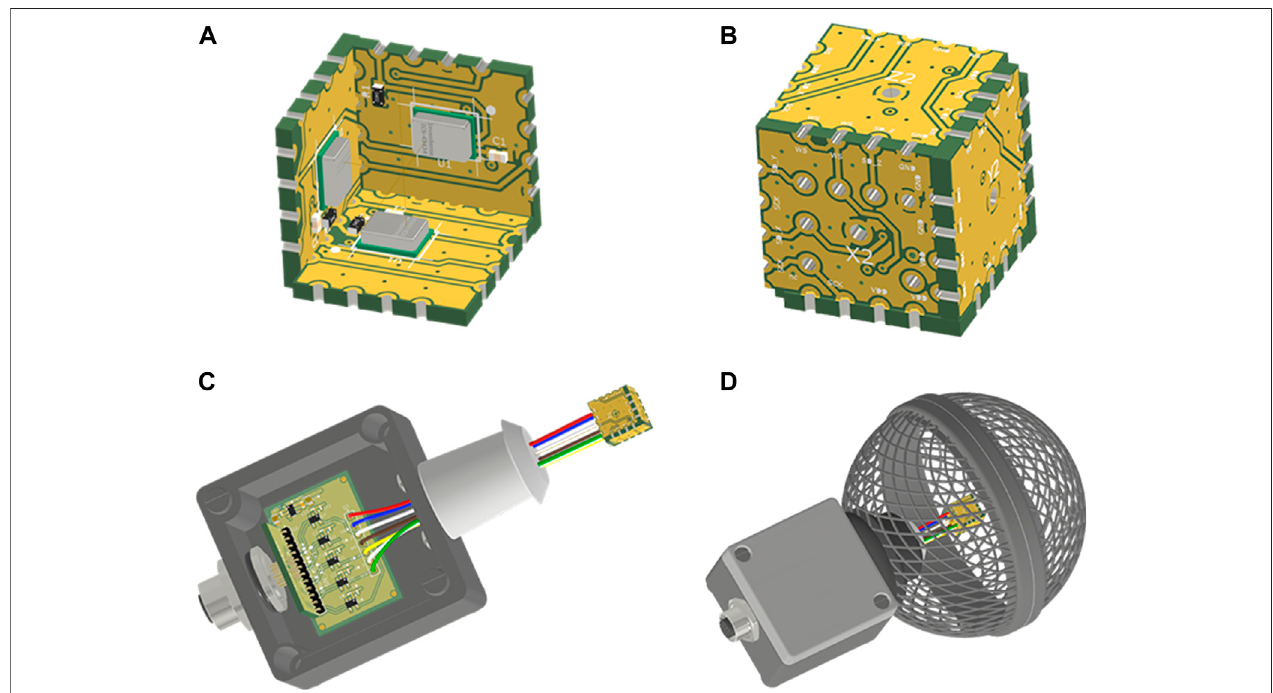
FIGURE 2 | Block diagram of the signal processing algorithm of the acoustic intensity probe developed in Gdansk University of Technology (Kotus and Szwoch, 2018)